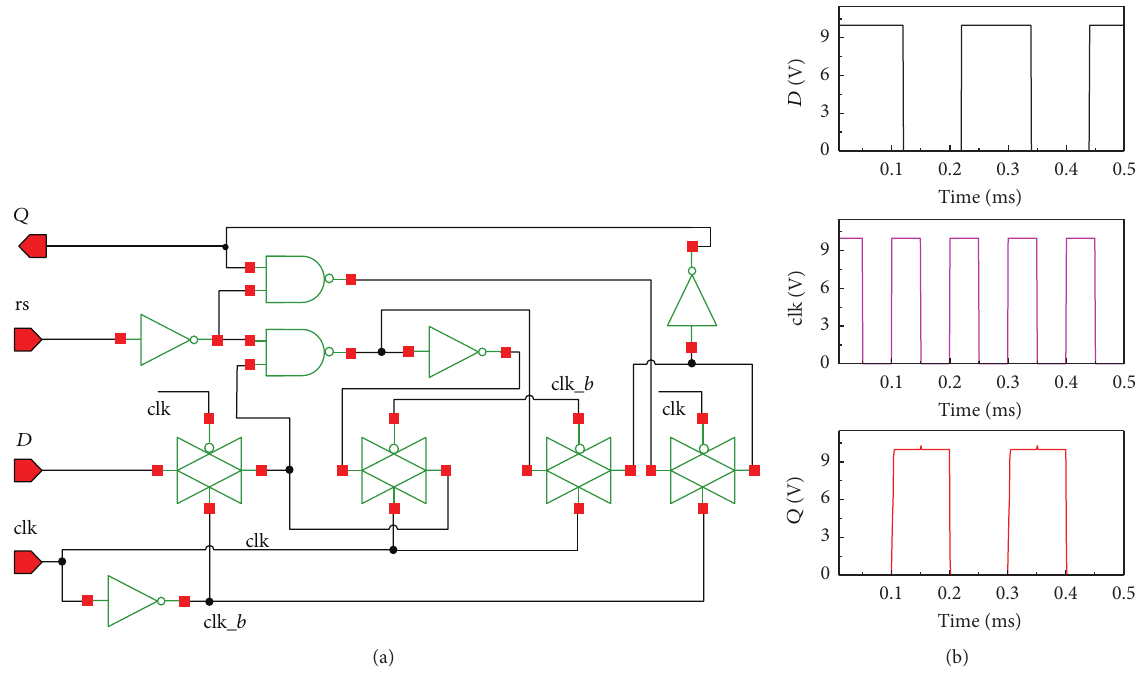
Figure 7: 𝐷 flip-flop: (a) topology and (b) simulation result at a clock frequency of 10KHz.